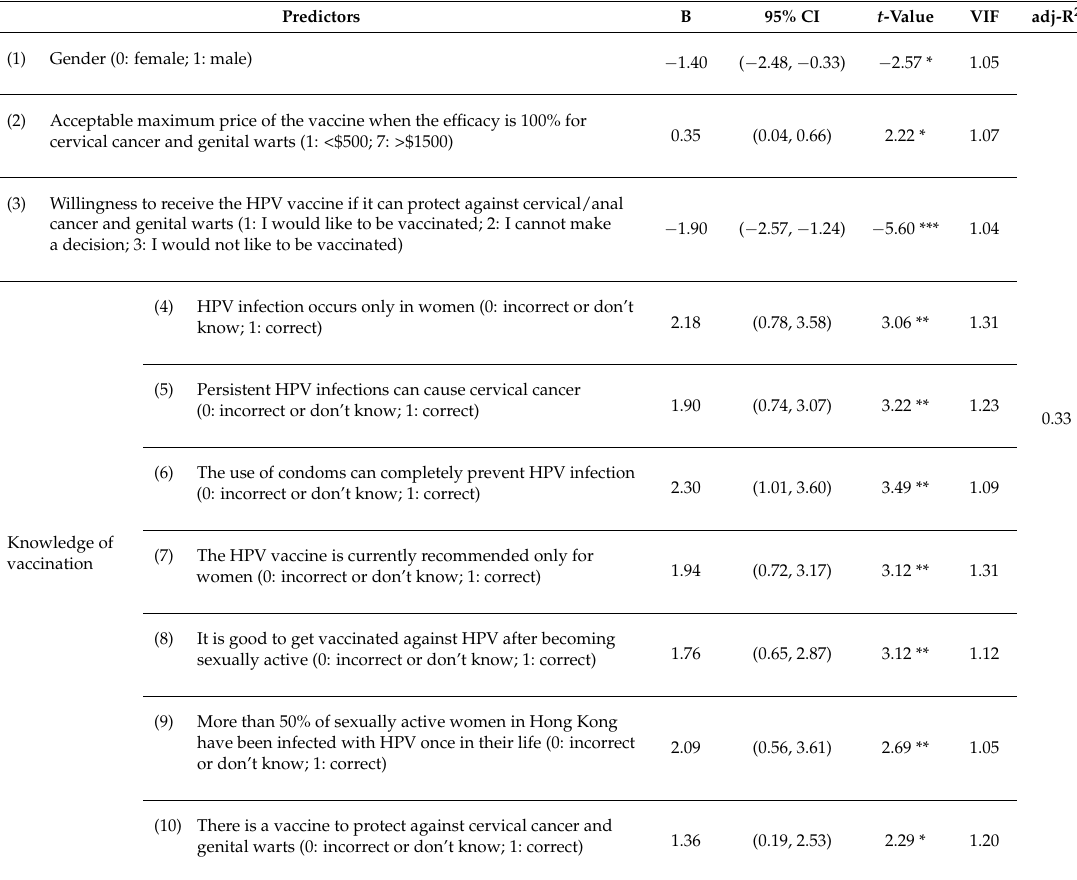
Table 6. Predictors of the respondents’ attitude towards receiving the HPV